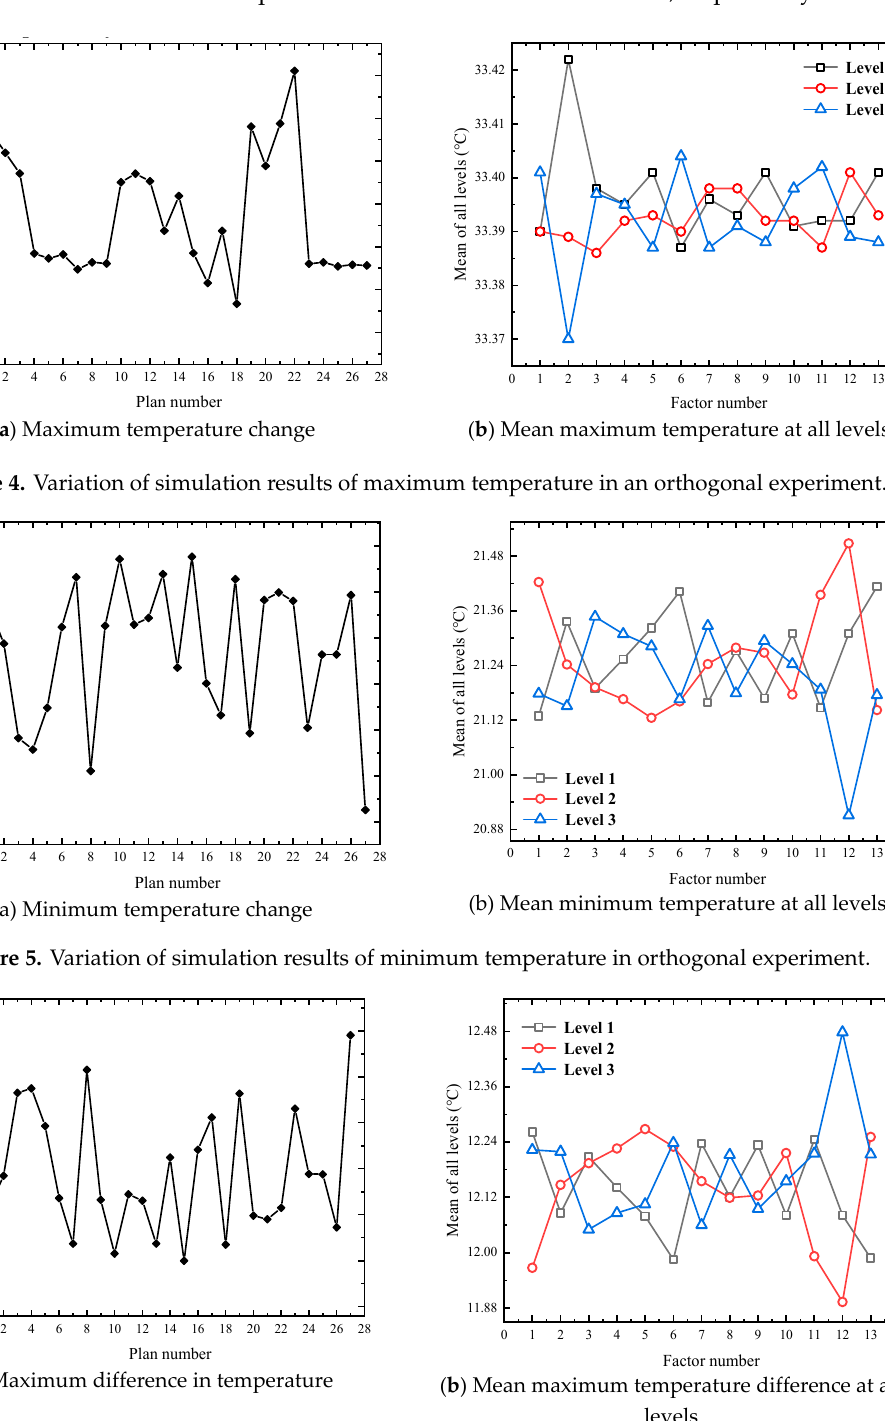
Figure 6. Variation of simulation results of maximum temperature difference in the orthogonal experiment.